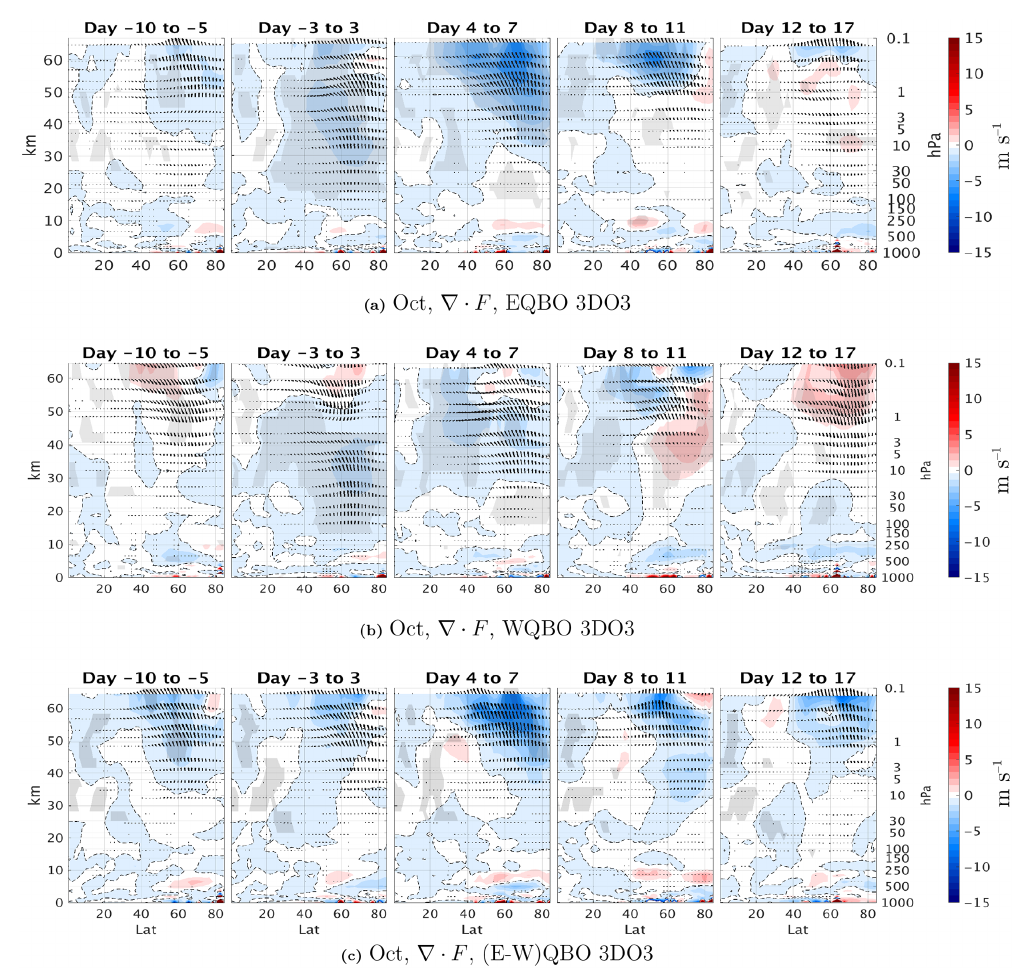
Figure 8. Latitude–height time lag composites of EP flux divergence (anomalies from the climatology) for the positive heat flux events (70th percentile of V (cid:48) T (cid:48) at 100mb, 85–45 ◦ N) for east (a) , west (b) , and the their differences (c) for October events for the 3DO 3 run. Statistically significant areas are shown by gray